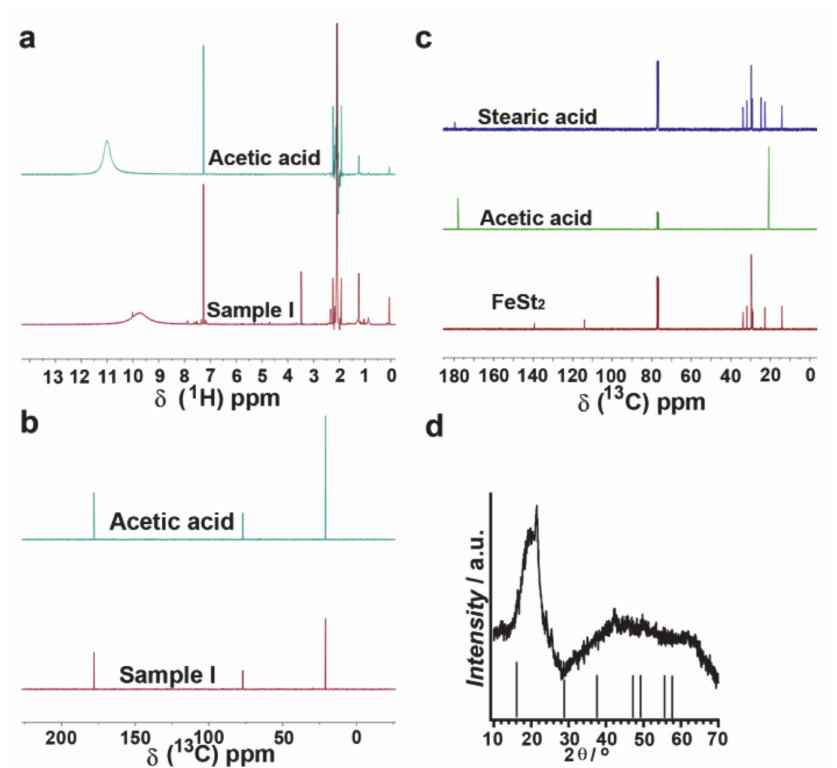
Figure 1. 1 H ( a ) and 13 C NMR ( b ) analysis of volatile species Sample I collected from ‘cold trap’. 13 C NMR analysis of the reaction intermediate, which was taken during Fe(Ac) 2 , reacted with SA in the presence of 1-ODE ( c ). X-ray Powder Diffraction (XRD) diagram of final product generated through hot injection of TBP-Se into iron precursor prepared by Fe(AC) 2 reacted with SA in the present of 1-ODE ( d